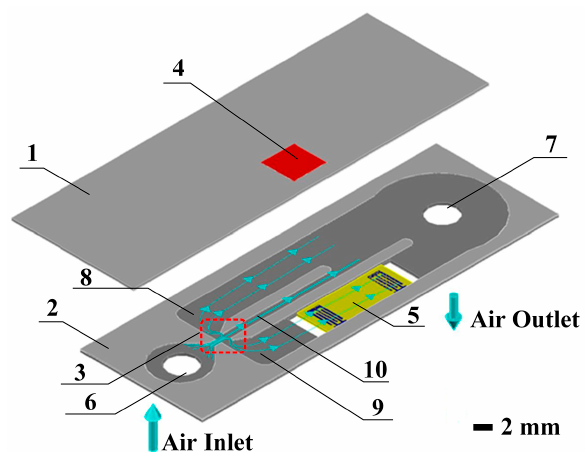
Figure 2. Exploded view of the detecting probe.